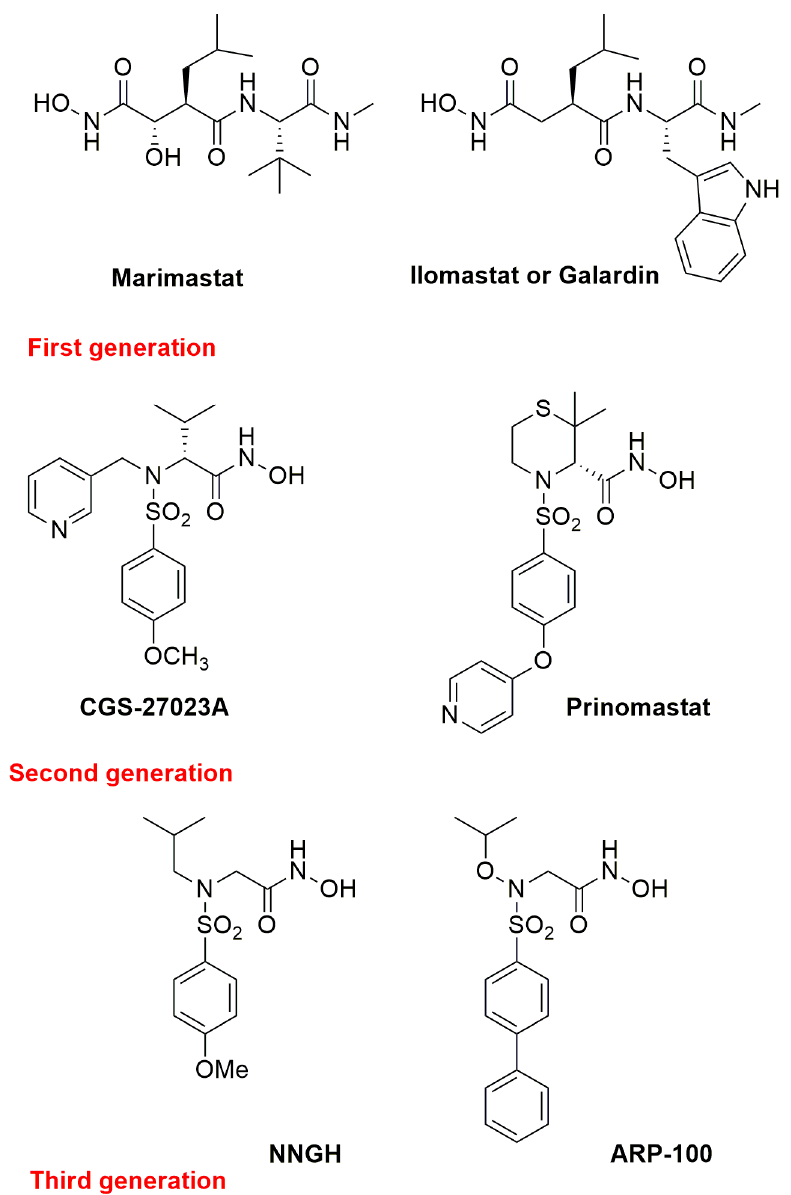
Figure 4. Chemical structure of the most representative zinc-chelating metzincin